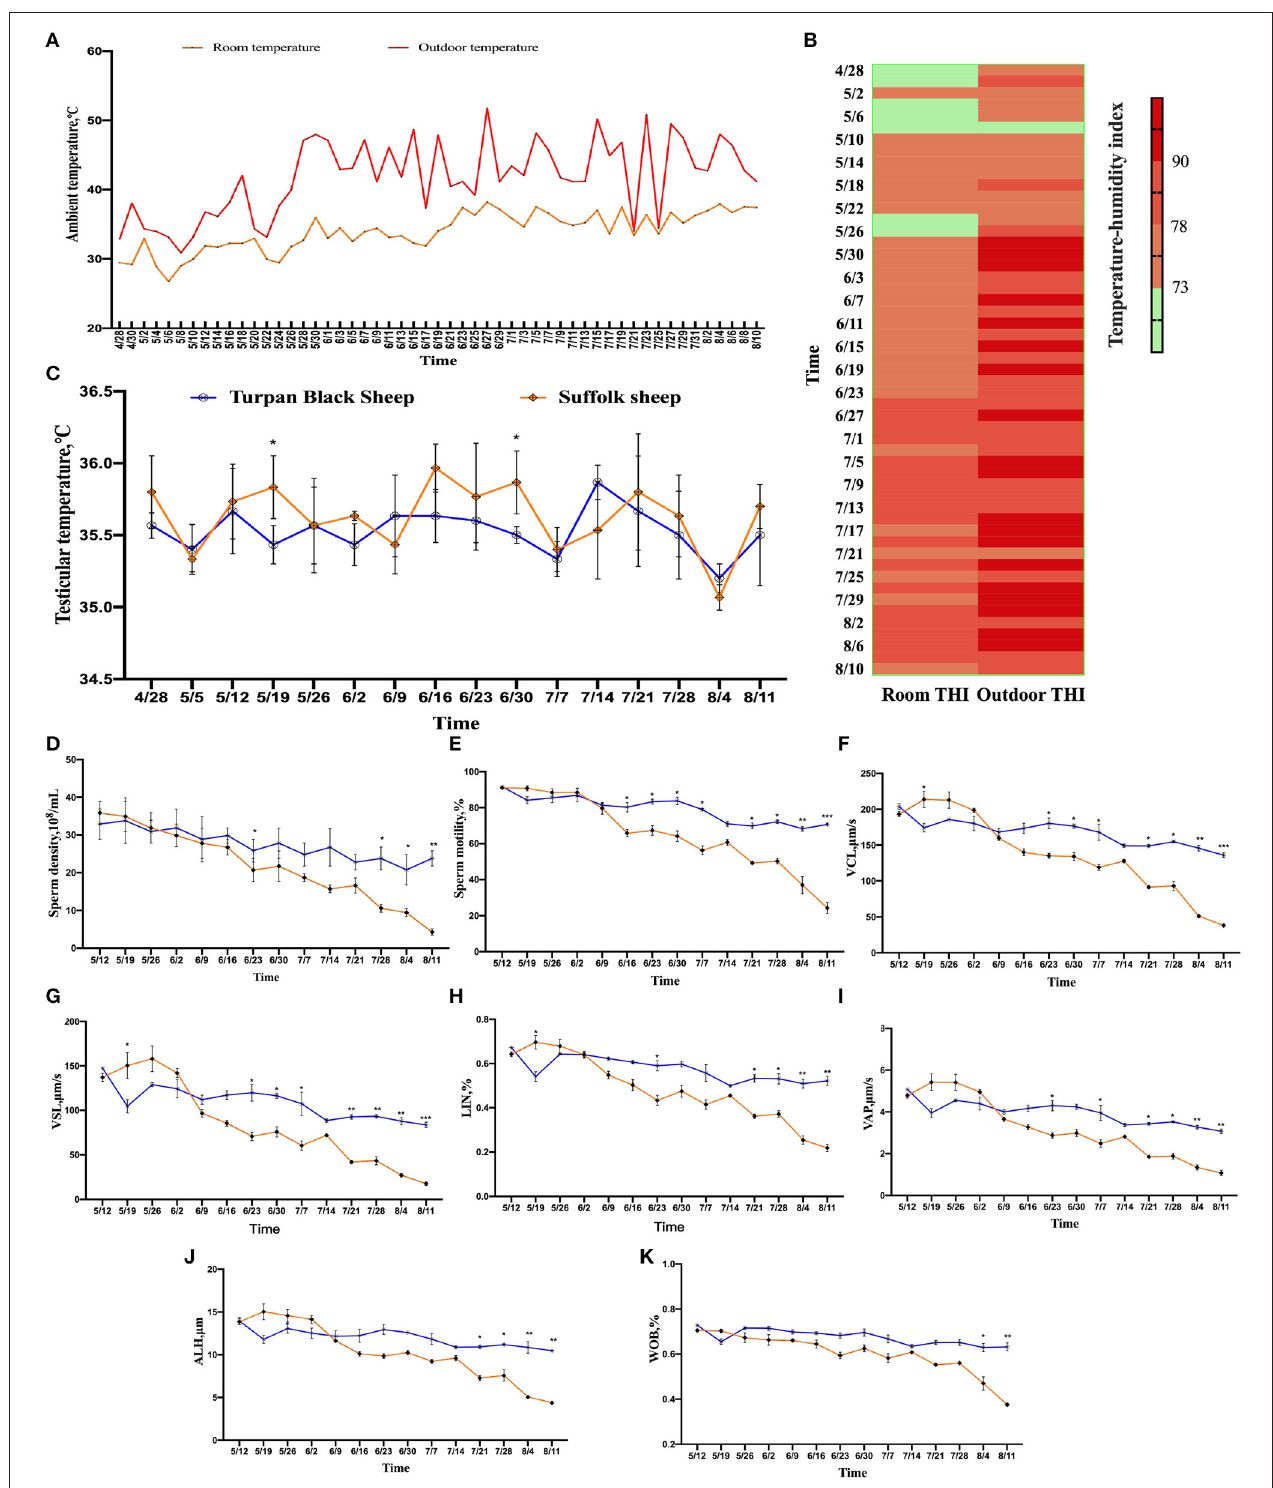
FIGURE 1 | Changes in environmental temperature and THI under heat stress. (A) Temperature changes inside and outside the shed from April 28 to August 10. (B) Temperature and humidity index change, the darker the color, the more serious the heat stress stimulation. Data were displayed through four measurements per day. (C) Testicular temperature changes during heat stress. (D–K) Continuous sampling of ram, and sperm motility parameters [ (D) density, (E) vitality, (F) Curve line velocity, (G) straight line velocity, (H) Sperm movement linearity, (I) Velocity of the average path, (J) Mean side swing amplitude of sperm, (K) Sperm